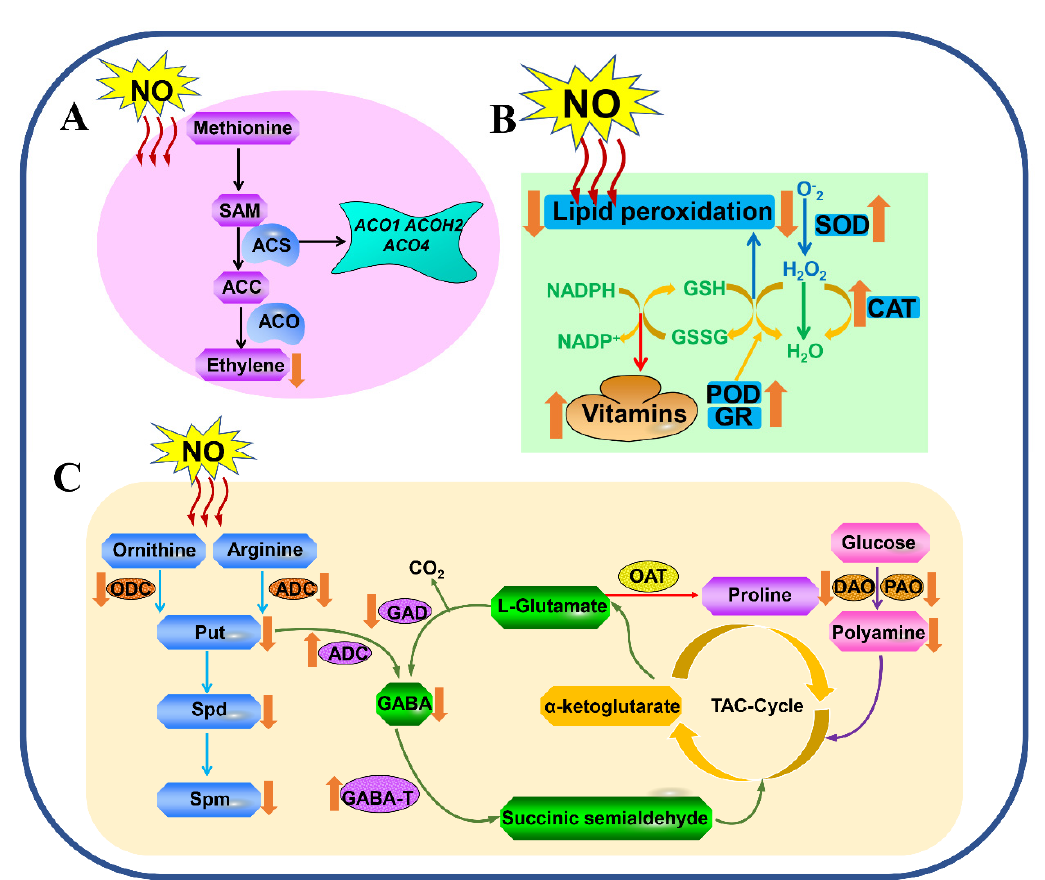
Figure 2. The regulatory mechanisms involving NO that are related to the postharvest senescence of plants: ( A ) ethylene biosynthesis, ( B ) the antioxidant system, ( C ) polyamine metabolism and γ -aminobutyric acid (GABA) shunting. SAM, S-adenosyl-methionine; ACS, 1-aminocyclopropane-1- carboxylate synthase; ACO, ACC oxidase; NO, nitric oxide; SOD, superoxide dismutase; CAT, catalase; POD, peroxidase; GR, Glutathione reductase; NADPH, NADPH oxidase; GSH, glutathione; GSSG, Oxidized glutathione; O − 2 , Superoxide radicals; H 2 O 2 , hydrogen peroxide; Put, putrescine; Spd, spermidine; Spm, spermine; ADC, arginine decarboxylase; DAO, diamine oxidase; PAO, polyamine oxidase; GABA, γ -aminobutyric acid.